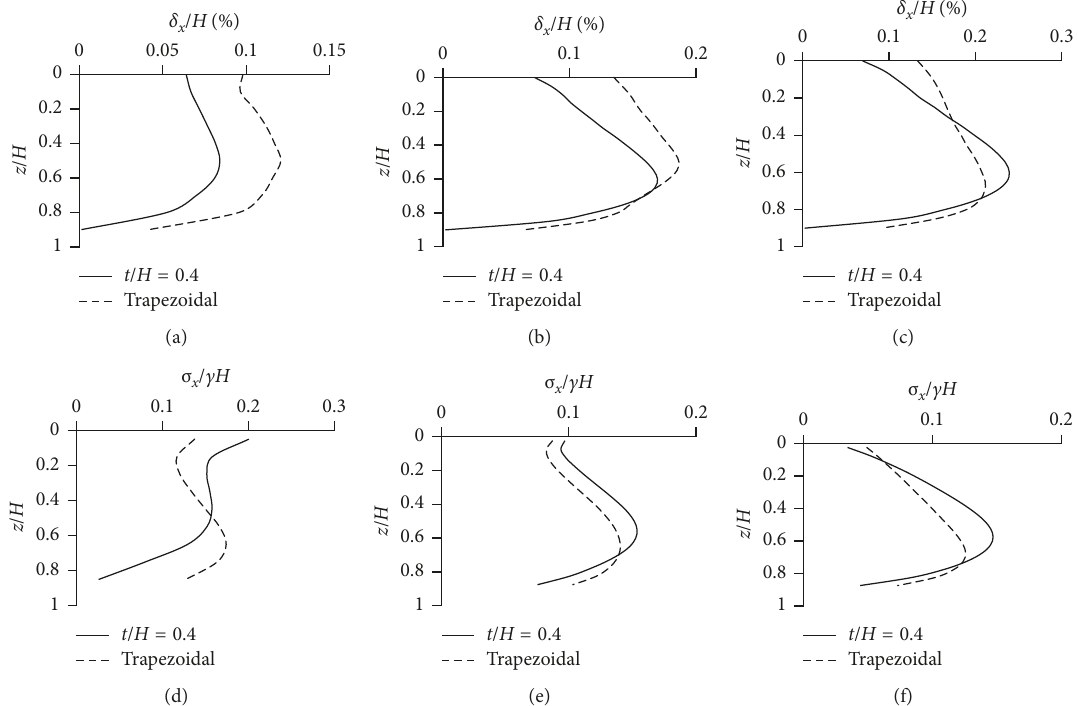
Figure 10: Effect of trapezoidal geofoam panel and one rectangular geofoam panel with the relative thickness of 0.4H on (a, b, and c) lateral displacements of soil and (d, e, and f) distribution of forces on nonyielding retaining walls. (a) H (e) H 6m. (f) H 9 m. (cid:31) (cid:31)